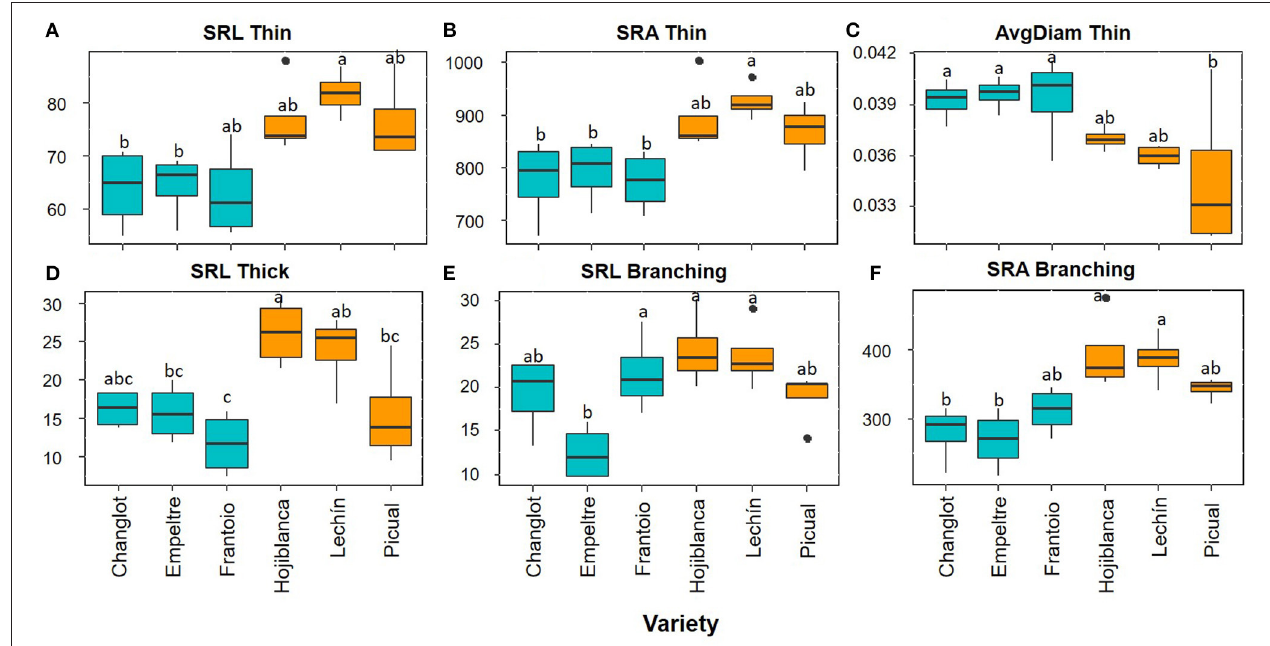
FIGURE 1 | Box plots showing median values ( n = 4) of SRL thin (“specific root length thin”) (cm g-1) (A) , SRA thin (“specific root area thin”) (cm 2 g − 1 ) (B) , AvgDiam thin (“root average diameter thin”) (cm) (C) , SRL thick (“specific root length thick”) (cm g − 1 ) (D) , SRL Branching (“specific root length branching portion”) (cm g − 1 ) (E) , and SRA branching (“specific root area branching portion”) (cm 2 g − 1 ) (F) . Tolerant cultivars are represented in light blue while the susceptible ones are shown in orange. Letters indicate Tukey’s post hoc tests at the p < 0.05 level, following